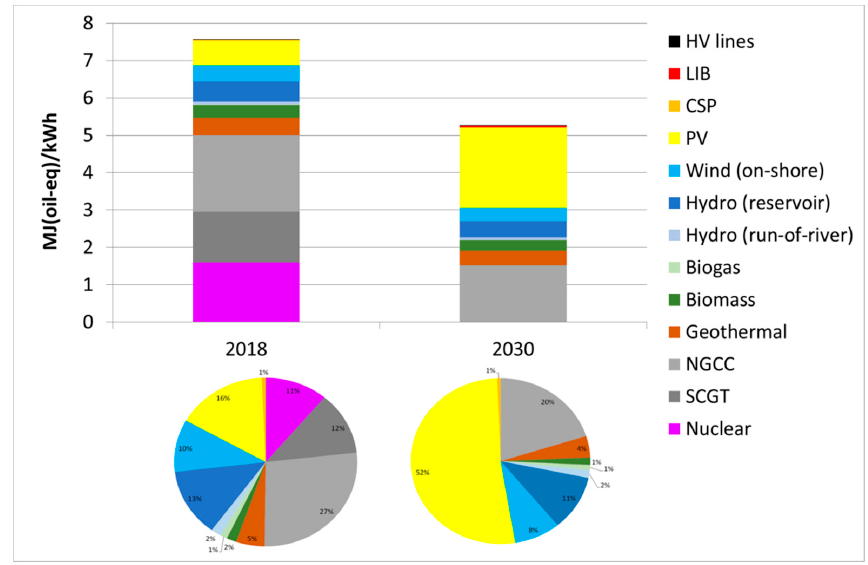
Figure 8. Cumulative energy demand (CED) results for California domestic grid mix in 2018 and in 2030. The pie charts underneath each bar refer to the corresponding grid mix composition, and are included to aid the interpretation of the results. SCGT = single cycle gas turbines; NGCC = natural gas combined cycles; PV = photovoltaics; CSP = concentrating solar power; LIB = lithium ‐ ion batteries; HV = high voltage.